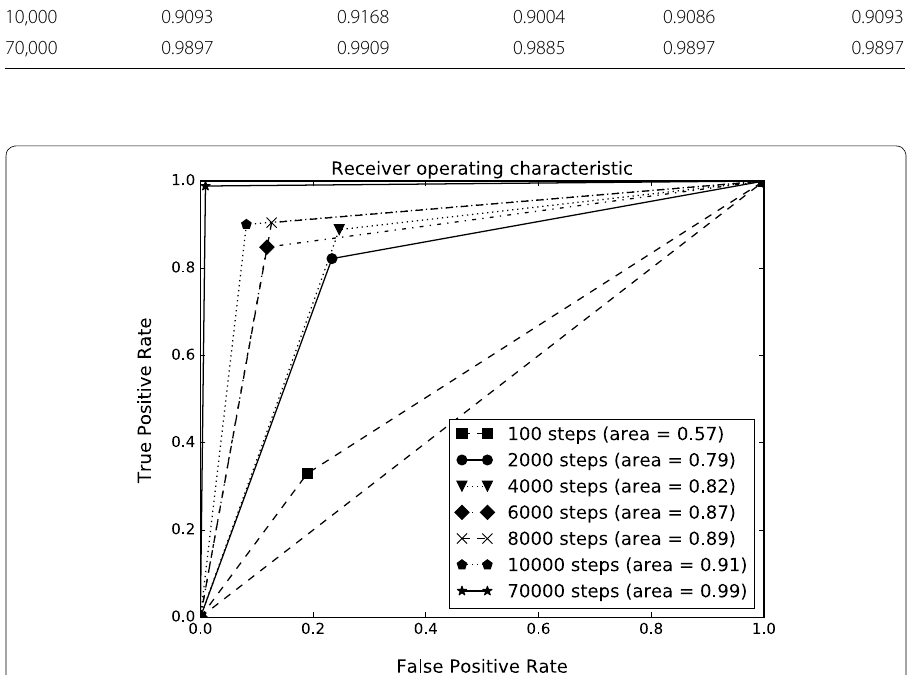
Fig. 7 Compare area under the ROC curve for convolutional neural network in various